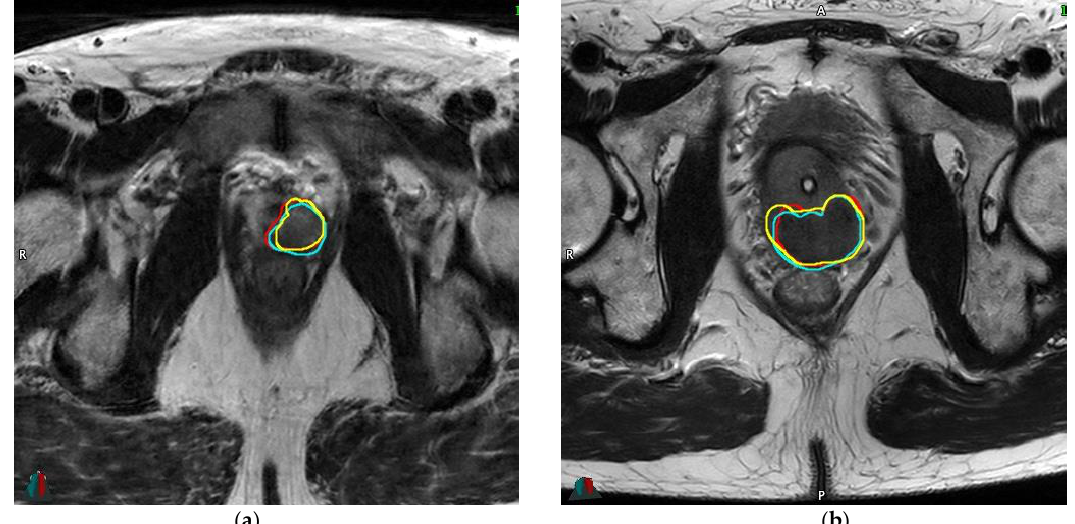
Figure 2. Example of variations of delineations for two patients: ( a ): 56.2 yo, cT2a, PSA 7.7 ng/mL, Gleason 3 + 4 (ISUP 2), respective DICE overlap coefficients with V.B (reference): 0.85 (F.L) and 0.83 (U.S); ( b ): 67.4 yo, cT1c, PSA 1.8 ng/mL, Gleason 4 + 4 (ISUP 4), respective DICE overlap coefficients with V.B (reference): 0.83 (F.L) and 0.81 (U.S). Abbreviations: yo: years old, PSA: prostate-specific antigen, ng: nanograms, mL: millimeter, ISUP: International Society of Urological Pathology. Red: delineation #1 (V.B), cyan: delineation #2 (F.L), yellow: delineation #3